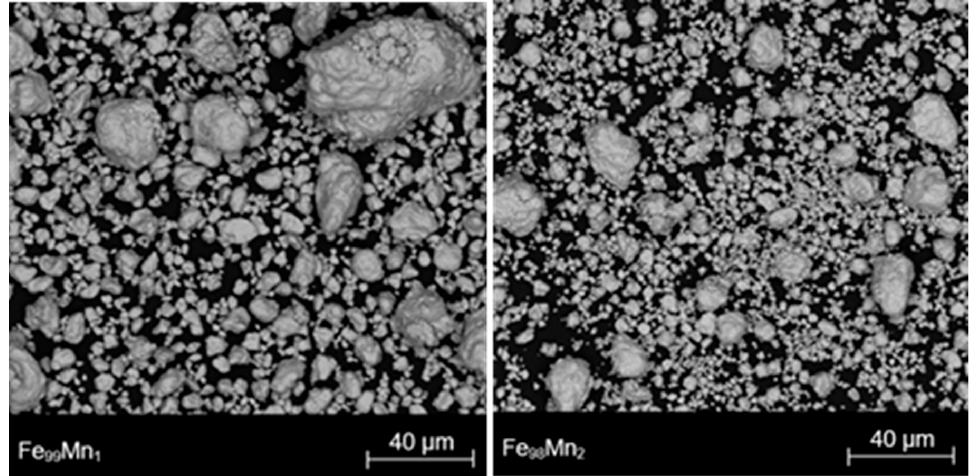
Figure 3. SEM images corresponding to samples of Fe 99 Mn 1 ( left ) and Fe 98 Mn 2 ( right ). EDX results for both samples show how no impurities are detected in the samples. Despite the low percentage in manganese, EDX spectra confirm the presence of Mn. EDX results for sample Fe 99 Mn 1 (Figure 4) detect 98.5% in atomic weight of Fe and 1.5% of Mn. For sample Fe 98 Mn 2 , EDX results detect 97.3% in atomic weight of Fe and 2.7% of Mn. The variability in chemical compositions could be due to the EDX analysis itself as it is a semiquantitative technique. It is known that the lower detection limit depends on element and acquisition time [15]. Due to the manufacturing conditions of mechanical alloying, Mn diffusion in the Fe matrix may not reach the necessary energetic conditions to achieve a homogenous Mn content within the alloys.